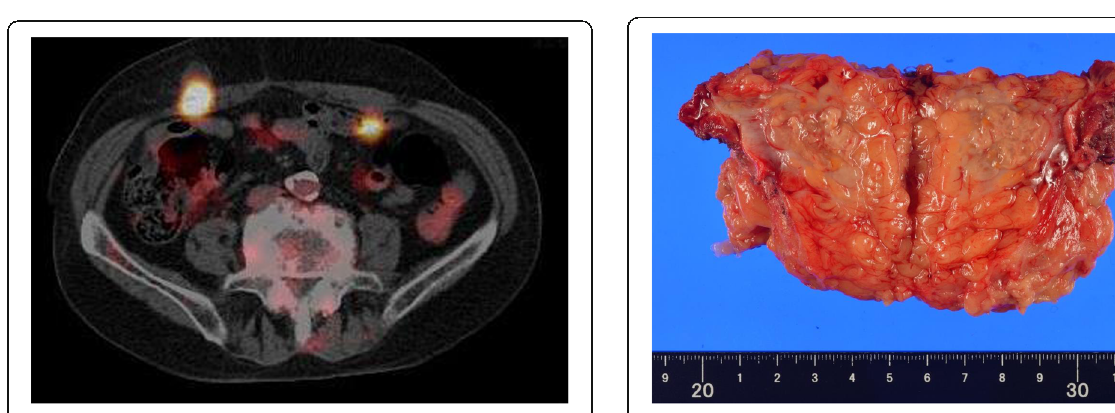
Fig. 3 Resected specimen. The center of the tumor showed necrotic